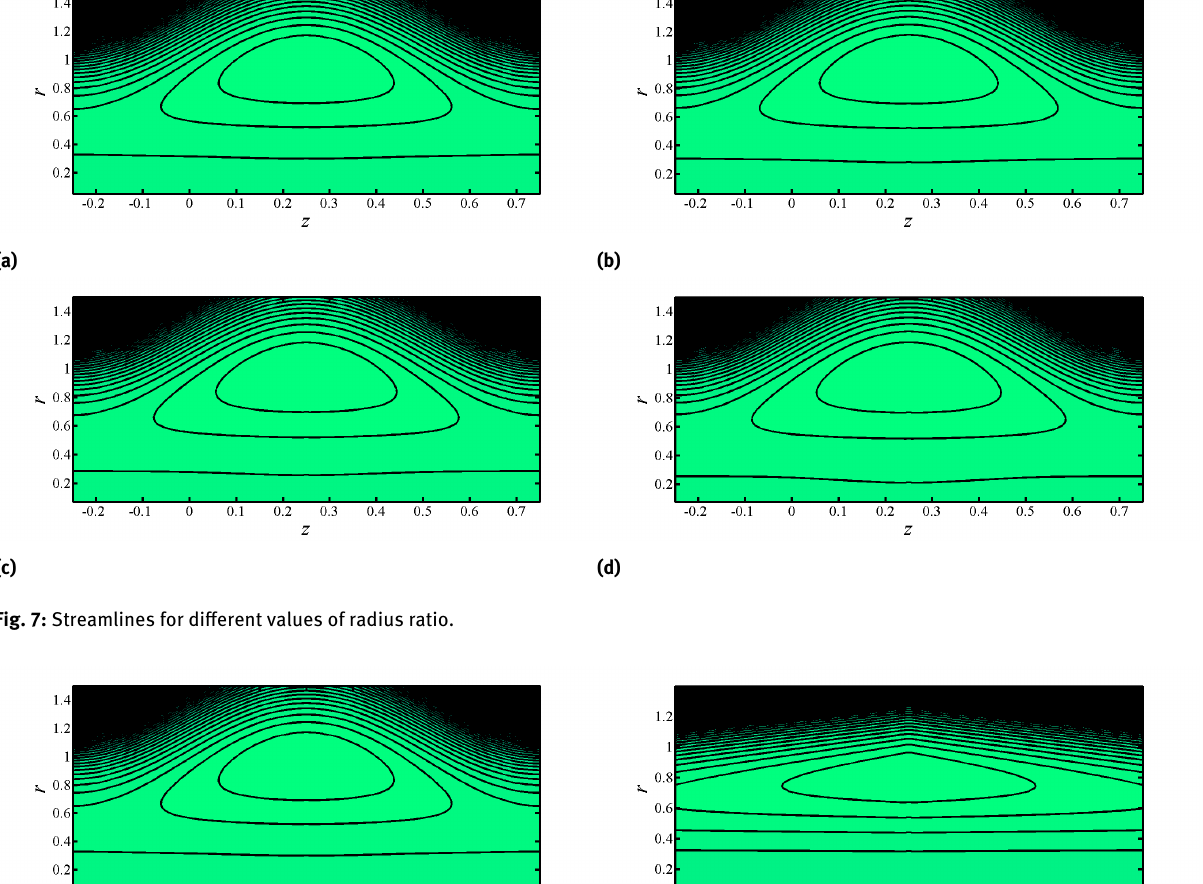
Fig. 7: Streamlines for different values of radius ratio.